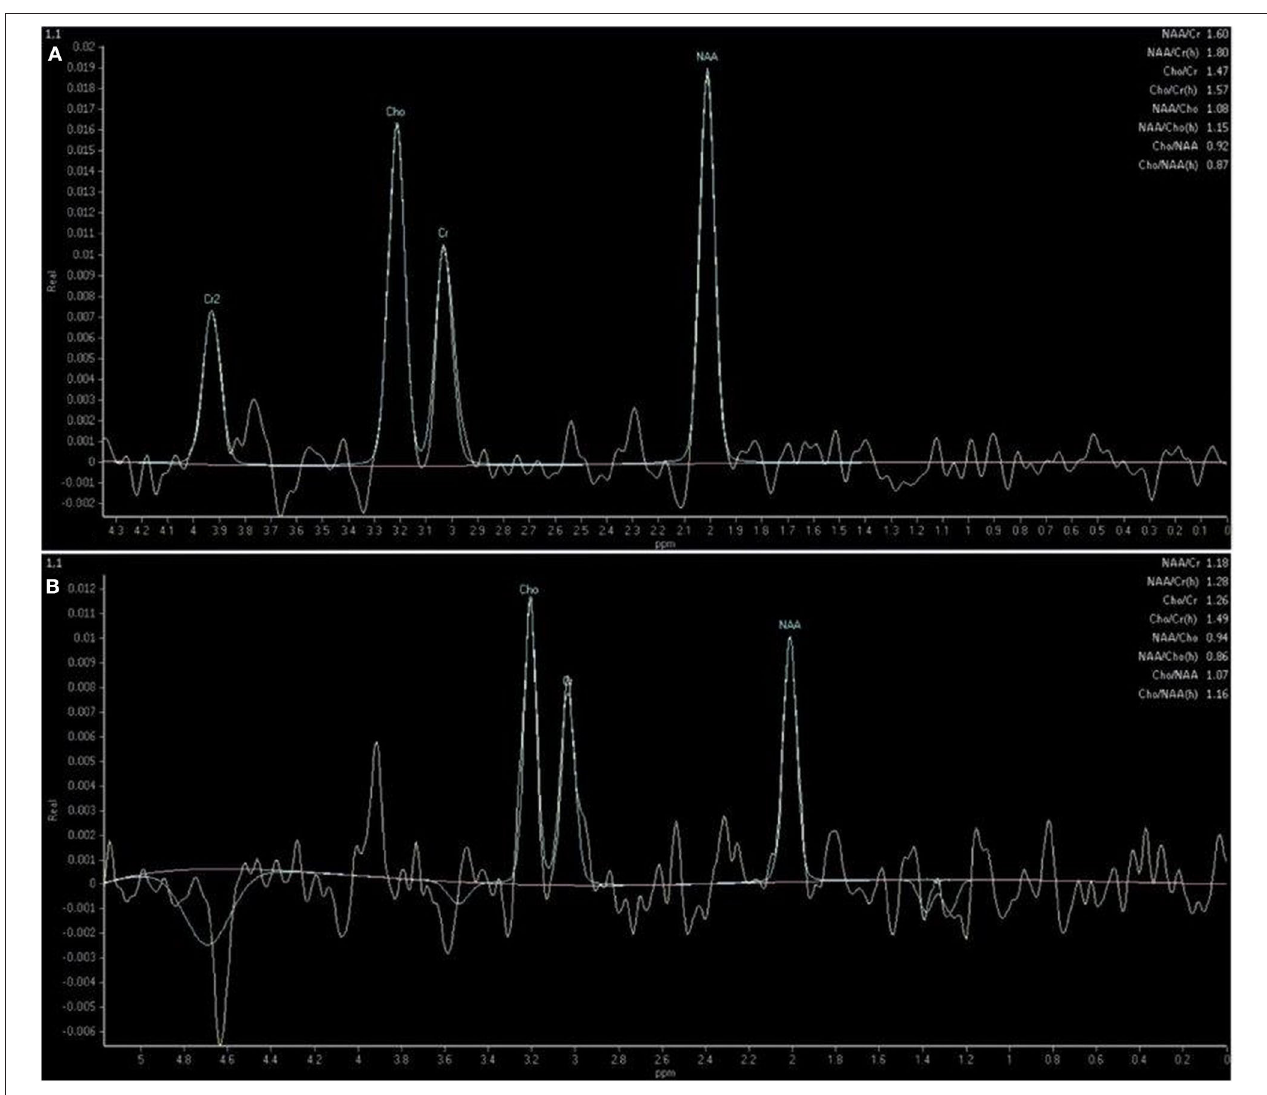
FIGURE 2 | Single-voxel spectrum acquired at the level of the temporal lobe showing metabolite peaks of N-acetylaspartate (NAA) at 2.0 ppm, creatine (Cr) at 3.0 ppm, choline (Cho) at 3.2 ppm and the calculated metabolite ratios in a mixed-breed dog with degenerative disc disease included in the control group (A) and in a 5-year-old mixed-breed male dog with idiopathic epilepsy and last seizure 7 days ago (B)